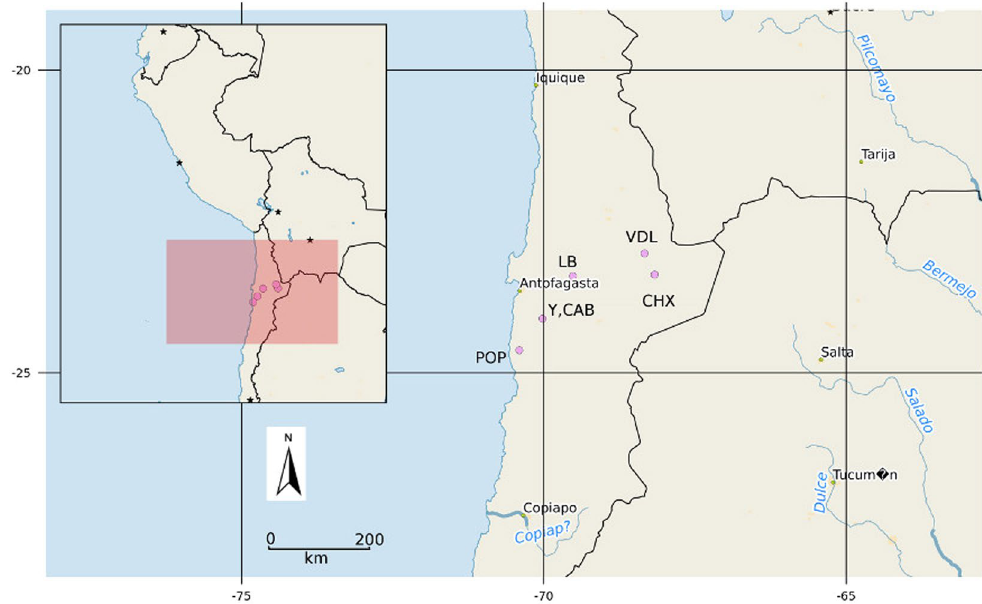
Figure 1. Location of Atacama Desert research in northern Chile. Site codes: Yungay (Y); Cerros Aguas Blancas (CAB); Lomas Bayas (LB); Cerro Paranal (POP); Salar de Atacama (CHX); Cordillera de la Sal (VDL). Map created by RAS from OpenStreetmap cartography (licensed under CC BY-SA http://www.openstreetmap. org/copyright © OpenStreetMap contributors) using QGIS version 2.14 (Open Source Geospatial Foundation